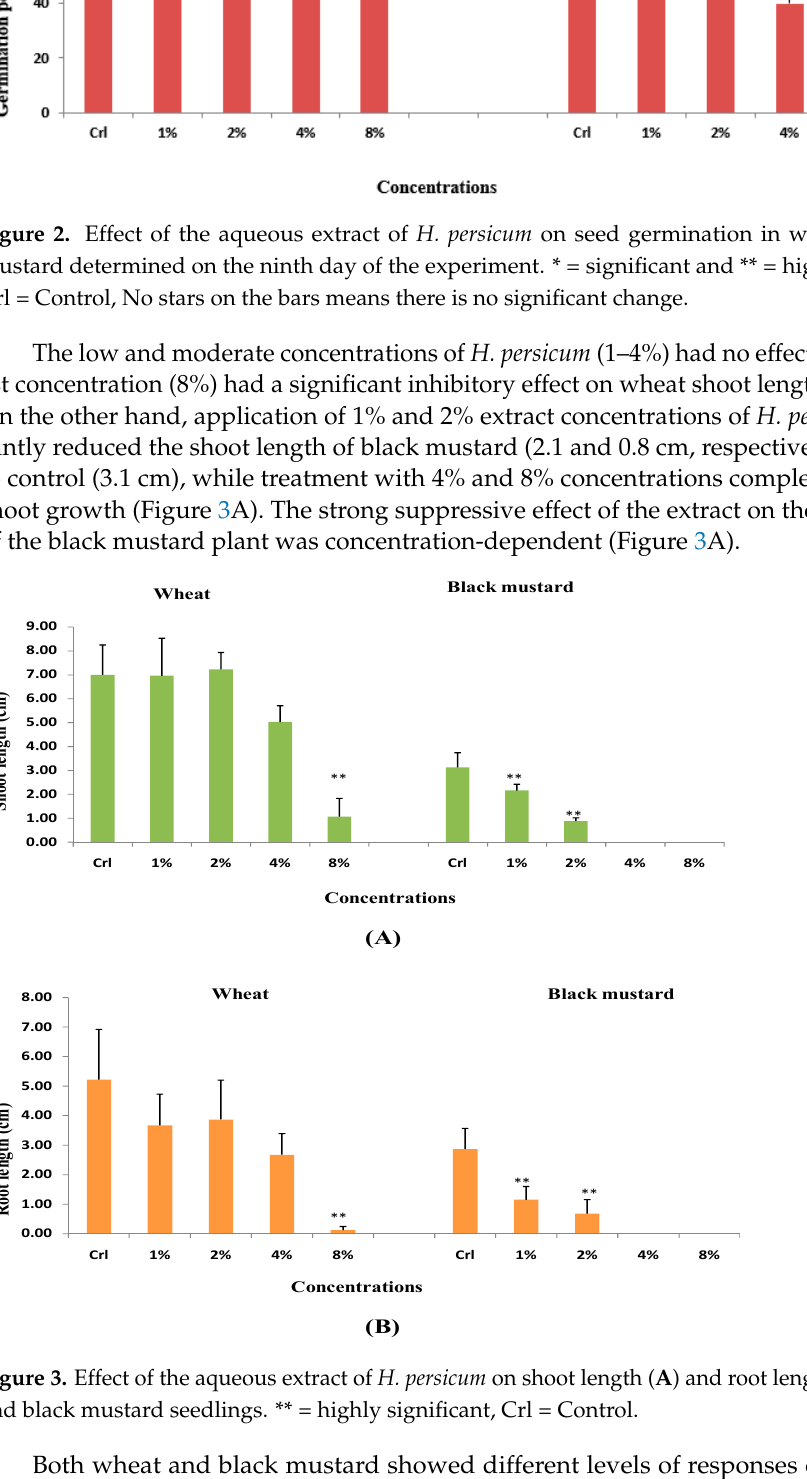
Figure 1. Effect of the aqueous extract of H. persicum on the germination rate of wheat ( A ) and black mustard ( B ).